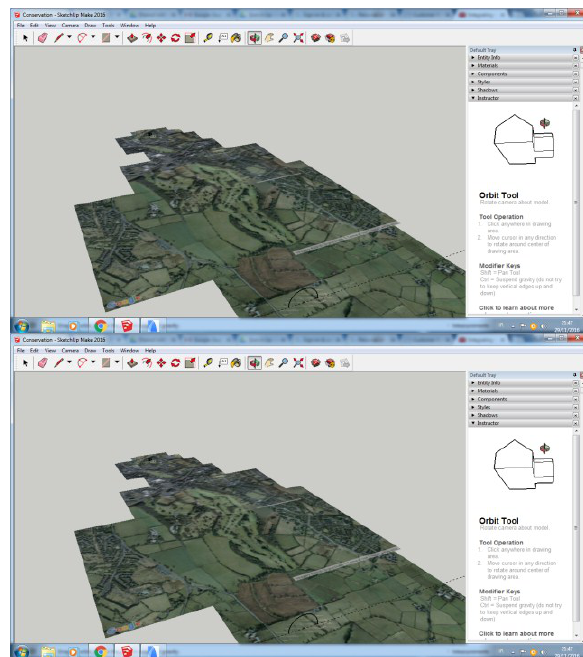
Figure 3: Landscape Virtual Model